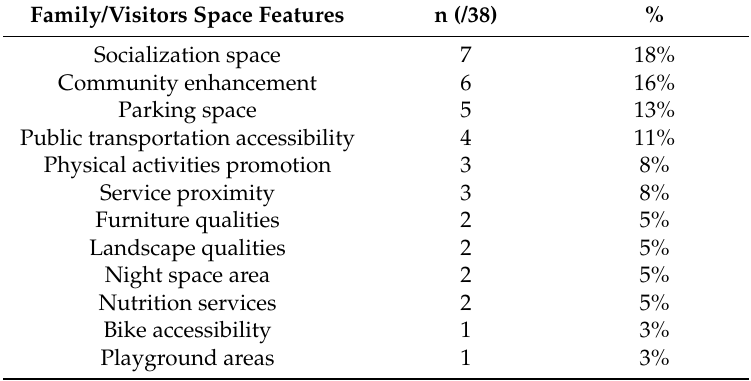
Table 9. Number and percentage of indicators grouped according to Family/visitors space features topics.